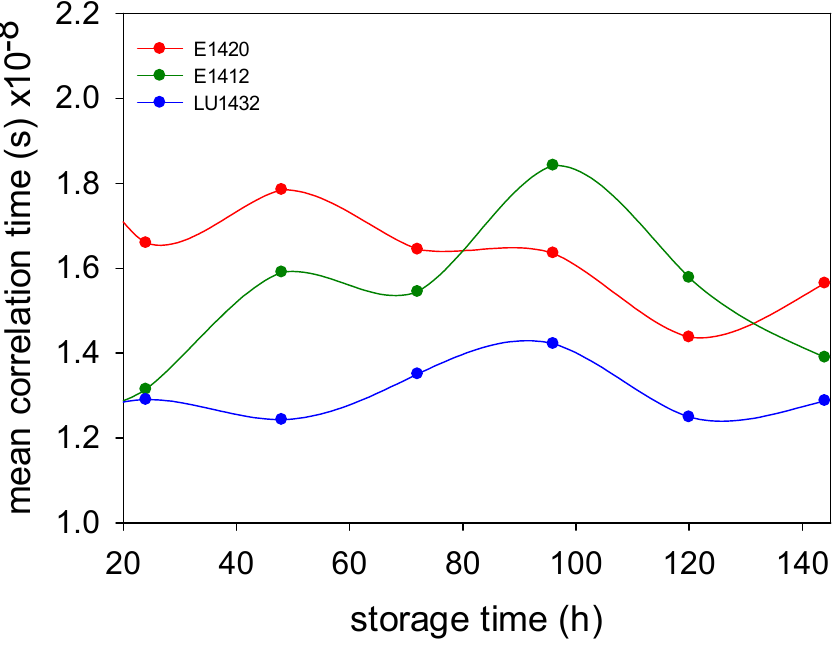
Figure 5. Time-dependent changes in mean values of proton motion correlation times of fat proton fraction in emulsions of bovine fat. Figures 6 and 7 show the time-dependent changes in the mean correlation times in the starch proton fractions ( T 12 and T 22 ) of the emulsion.